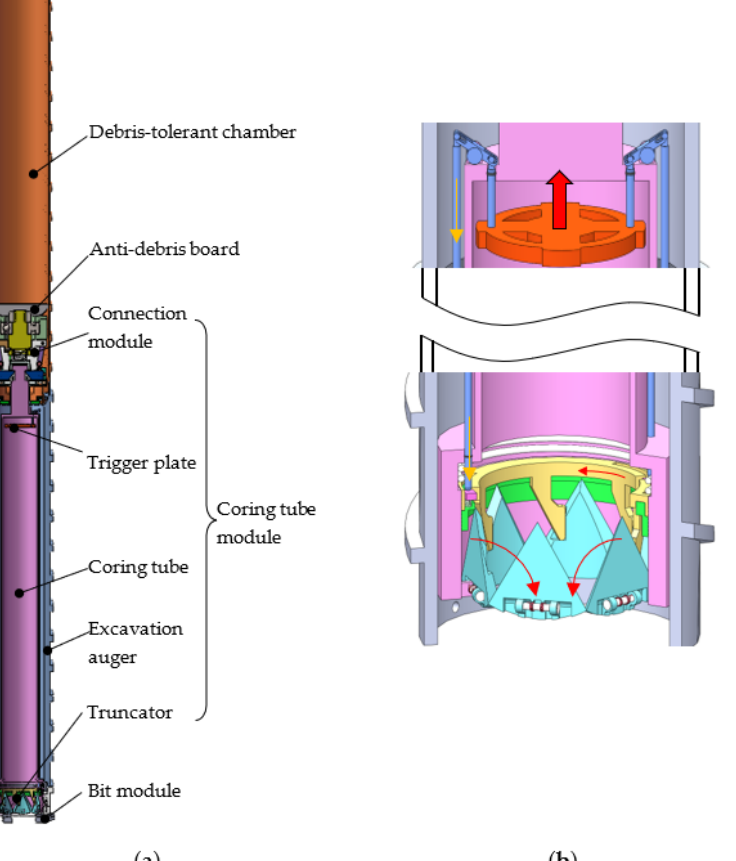
Figure 6. Design of the coring part ( a ) Modules configuration ( b ) Operating mechanism of truncator.